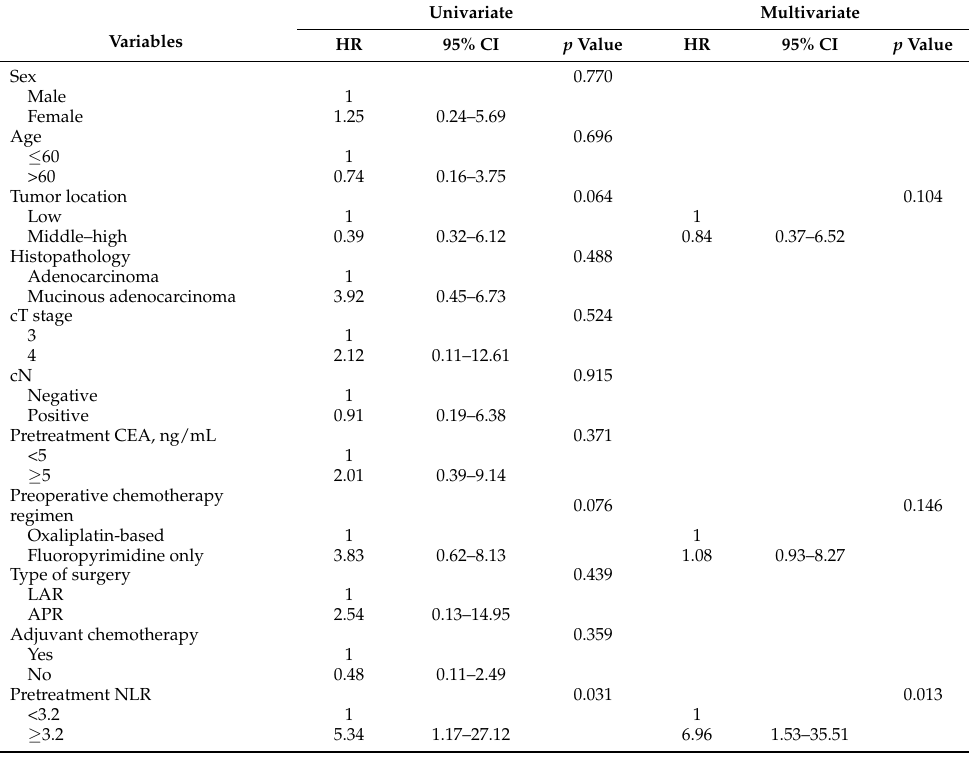
NLR: neutrophil-to-lymphocyte ratio; LAR: low anterior resection; APR: abdominoperineal resection; HR: hazard ratio; CI: confidence